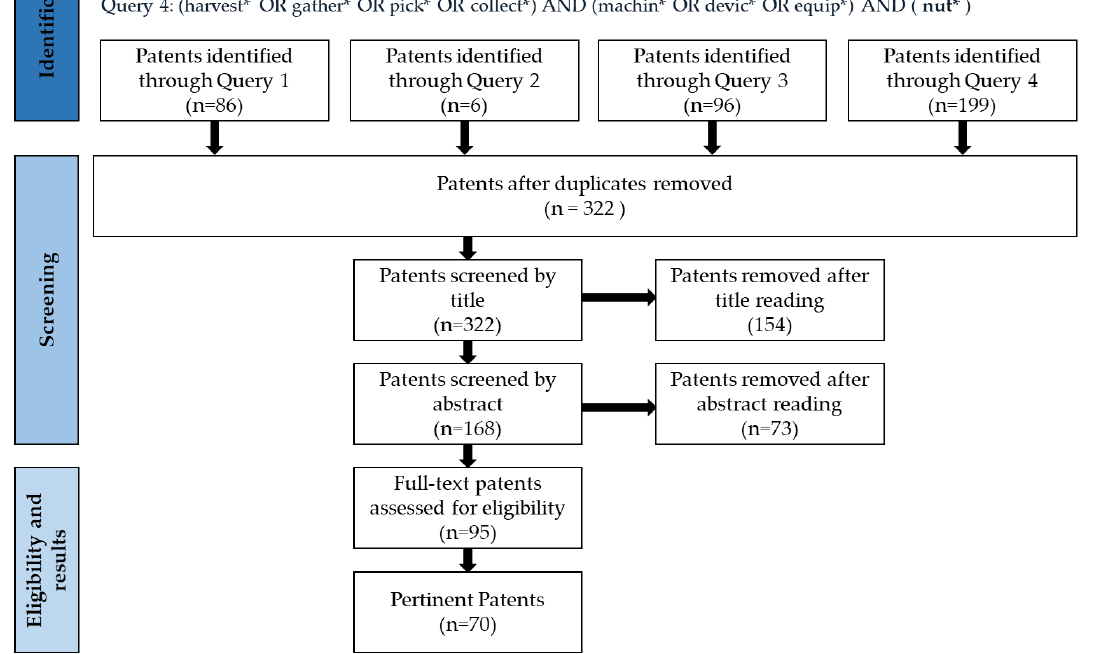
Figure 4. Search, screening, and selection results of the process to individuate relevant patents in the field of harvesting machines for shell fruits.